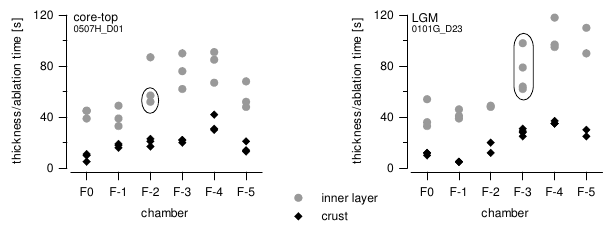
Fig. 4. Intra-test layers thickness pattern in N. dutertrei , examples from a core top (left) and an LGM (right) specimen from sediments from the SE South African margin. Each pair of a grey dot and a black diamond represents a single measurement. Encircled dots are minimum values only, in cases where the wall was not completely ablated. For chamber coding see Fig.